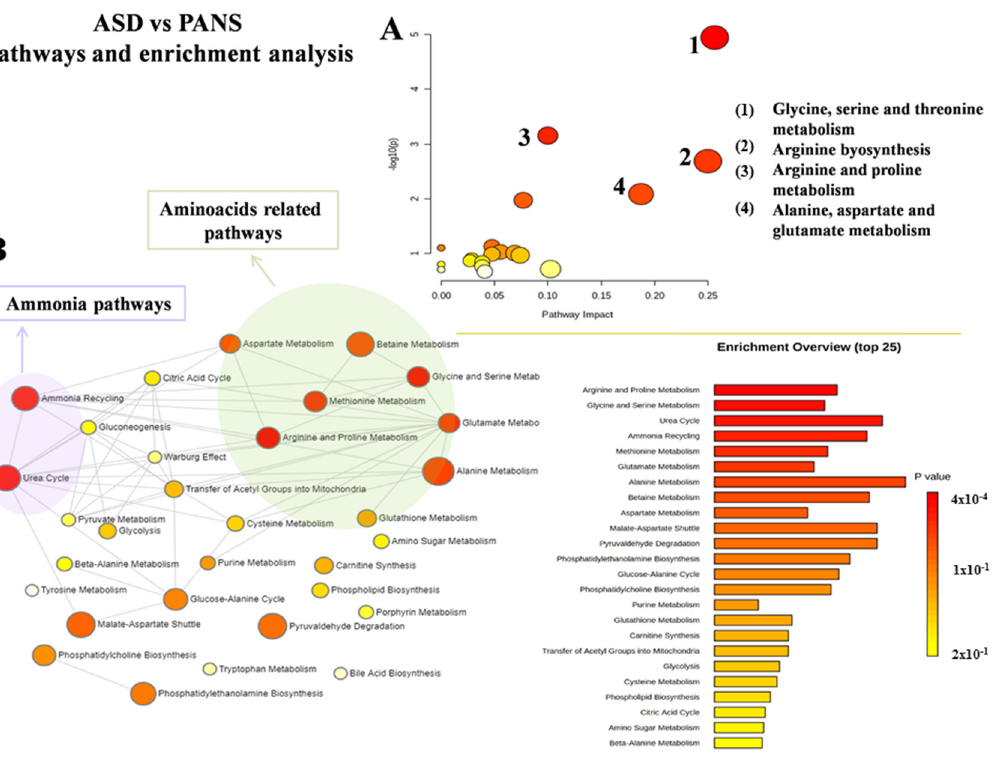
Figure 4. Metabolic pathways’ analysis ( A ) and enrichment analysis ( B ) of the comparison between ASD (autism spectrum disorder) and PANS (pediatric acute-onset neuropsychiatric syndrome) patients.